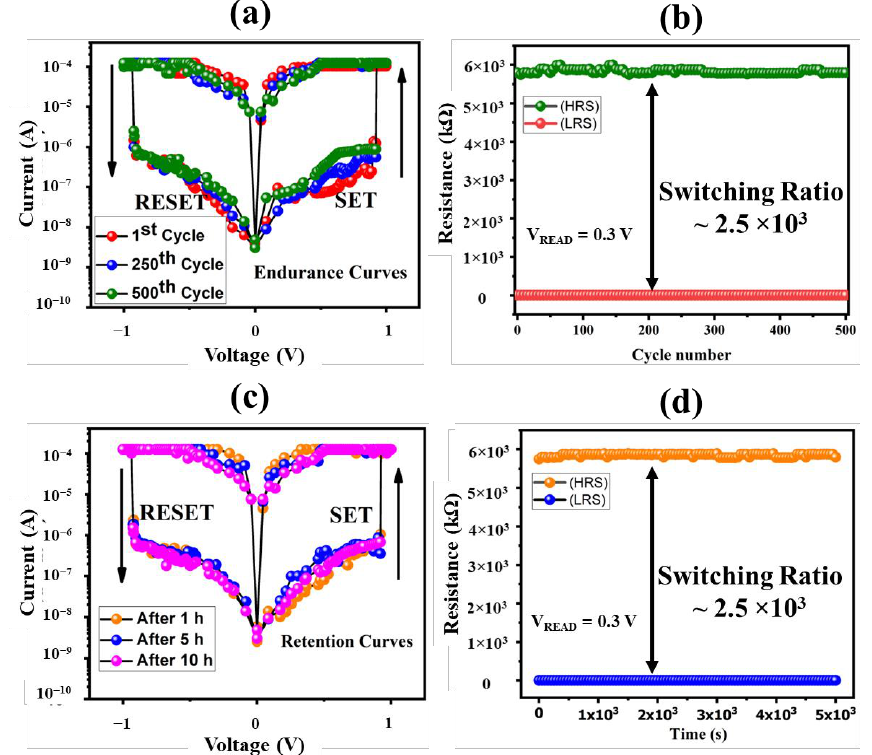
Figure 5. Electrical characteristics of metal–non-metal-doped TiO 2 based memristor. ( a ) Multiple I-V curves of fabricated memristor for 1st, 250th and 500th voltage sweep. ( b ) Stability graph of HRs and LRS for 500 voltage sweeps. ( c ) Multiple I-V curves of fabricated memristor after 1 h, 5 h, and 10 h, respectively. ( d ) Retention graph of HRS and LRS for 14 h.